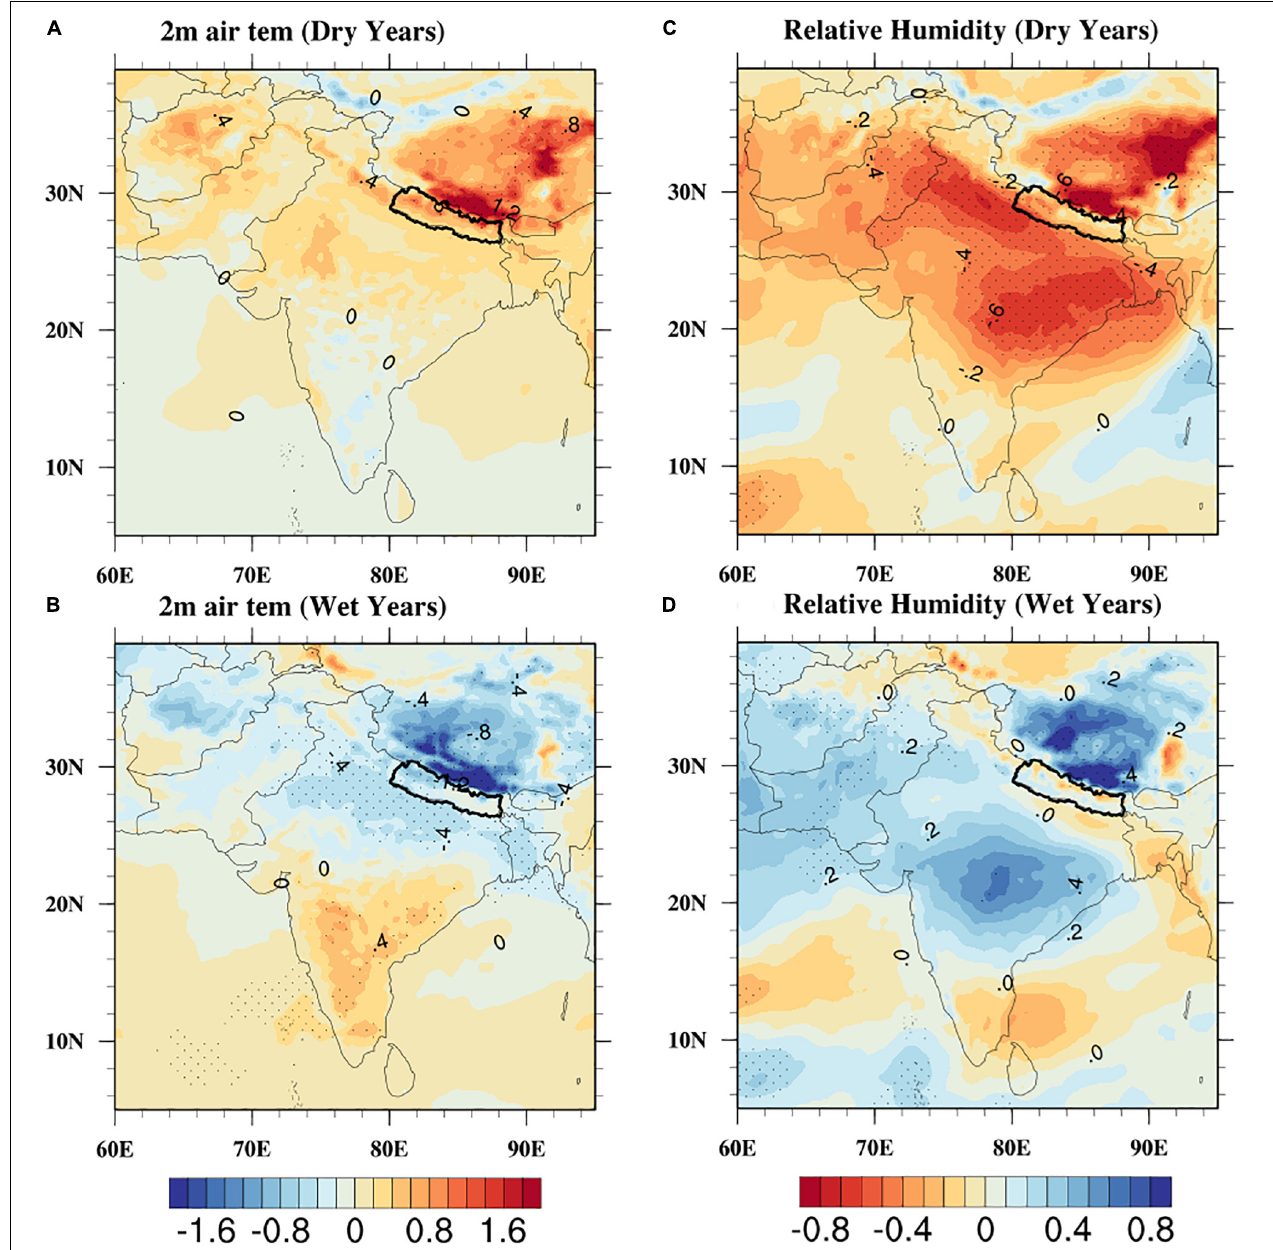
FIGURE 11 | Composite 2 m surface air temperature ( ◦ C) for (A) dry years, (B) wet years, and relative humidity (10 − 1 , %) during (C) dry years, and (D) wet years based on ERA5 reanalysis data from 1987 to 2015. The dotted points represent the significance at a 95% confidence level.